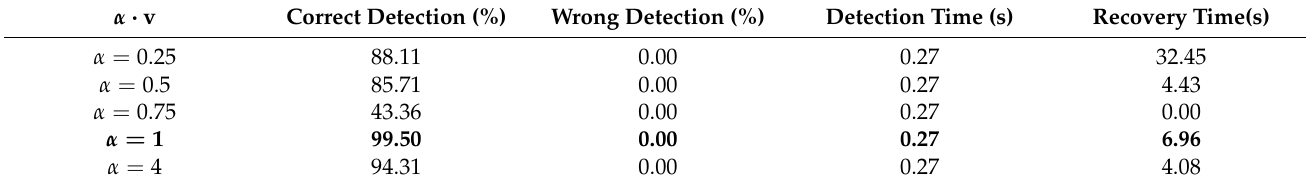
Table 7. Sensitivity analysis for varying of v